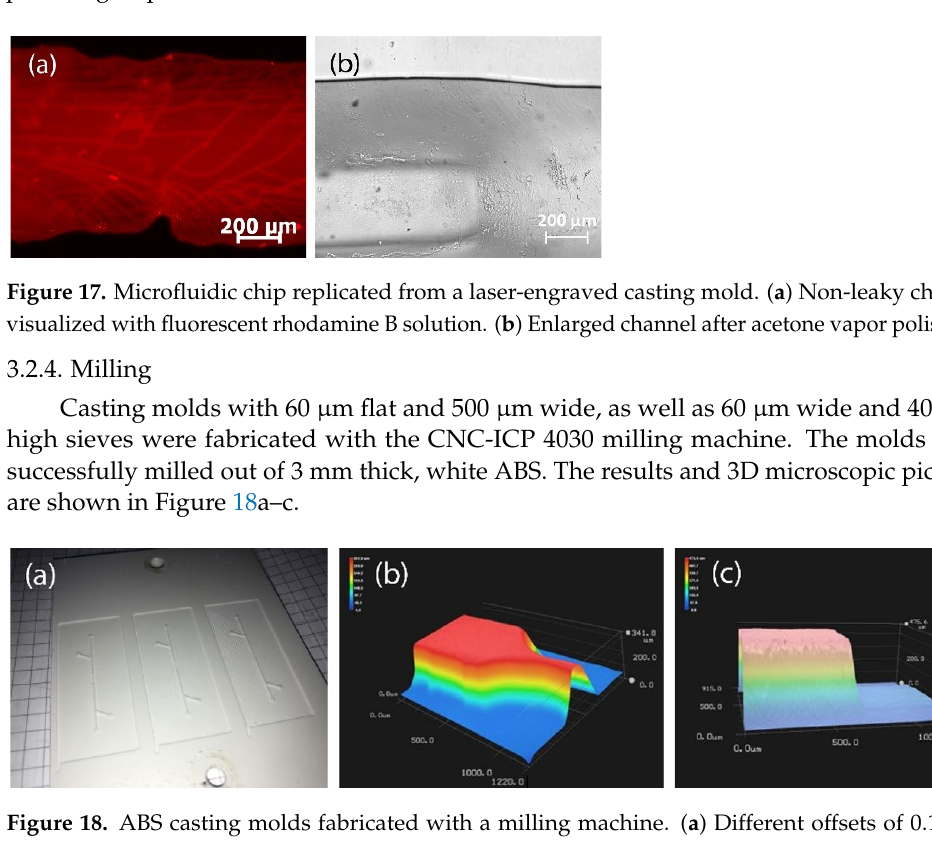
Figure 19. Microfluidic chip replica fabricated through milling on ABS. ( a ) Leakage visualized with fluorescent rhodamine B solution. ( b ) Narrow sieve retaining spherical particles. ( c ) Narrow sieve retaining non-spherical particles. The ABS casting molds were exposed to acetone vapor to smoothen the surface, and hence to minimize leakage of the final microfluidic chip. At first, a narrow sieve casting mold was polished for 20 min in a 70 °C heated vapor bath. Afterwards, the microfluidic chip could still be filled with particles and no leakage around the channel was observed